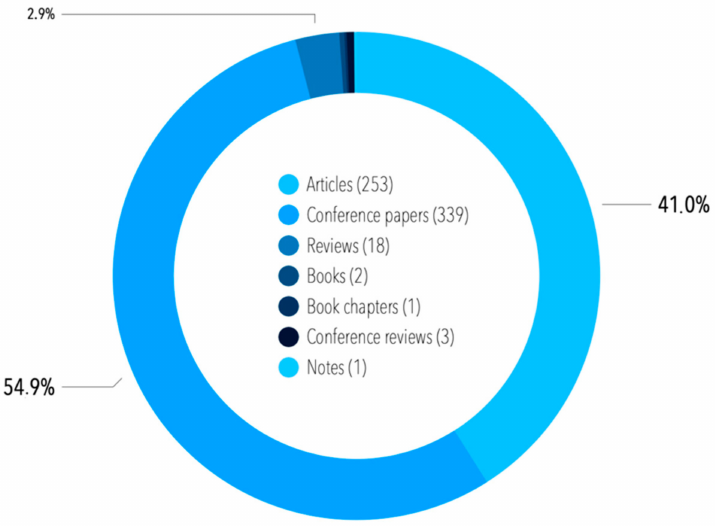
Figure 7. Percentage of publications per document type for the internal keywords connected to condition